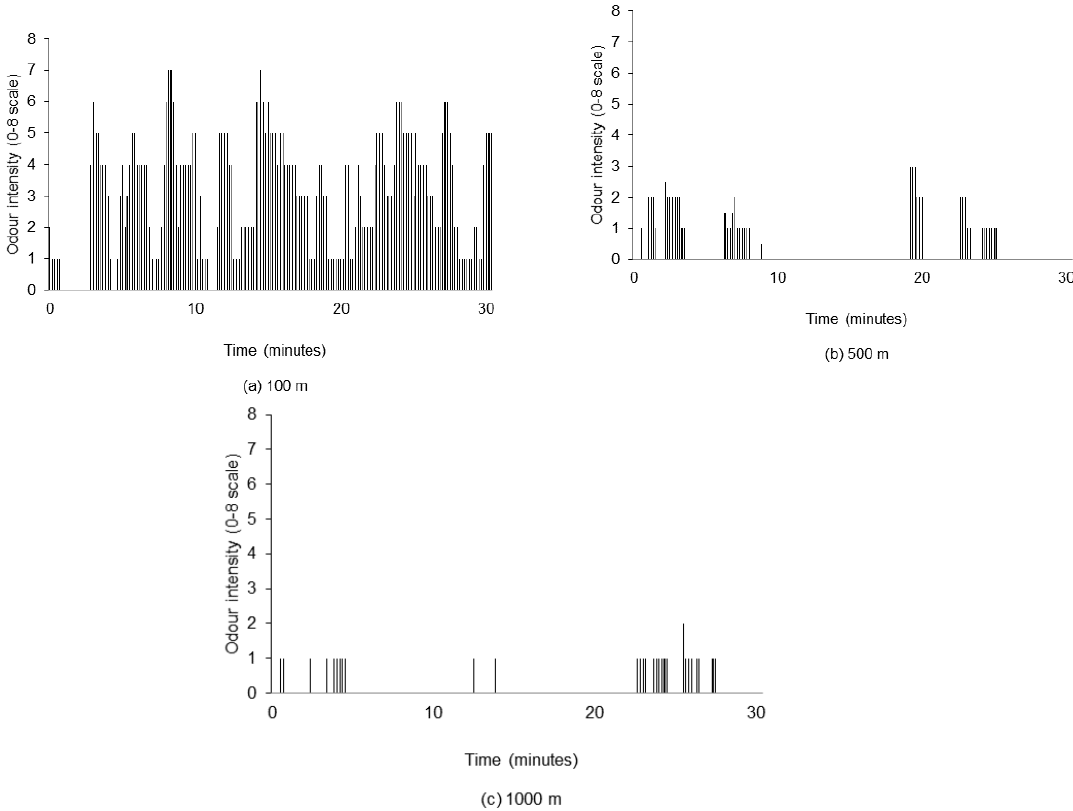
Figure 4. A sample of field odour intensity measurements reported by human assessors in a 30 minute sniffing session at: (a) 100 m, (b) 500 m, and (c) 1000 m from odour source (August 5, Session 2).